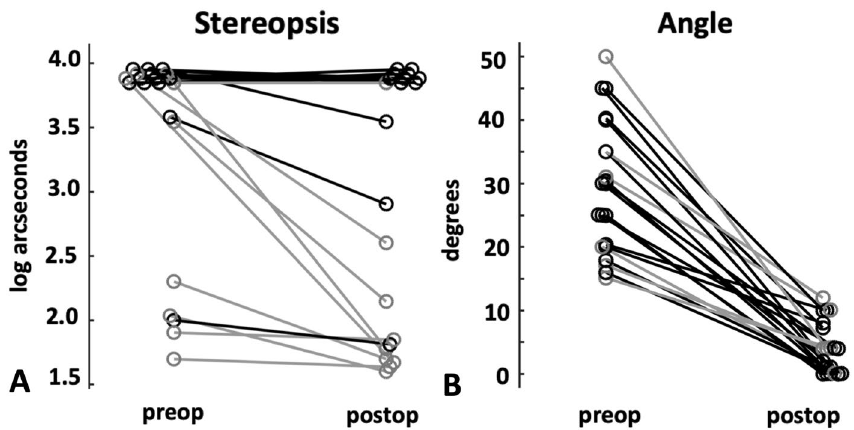
Figure 4. Pre-and postoperative strabismus angle ( A ) and stereopsis ( B ) in subjects with nystagmus (black) and in subjects without nystagmus